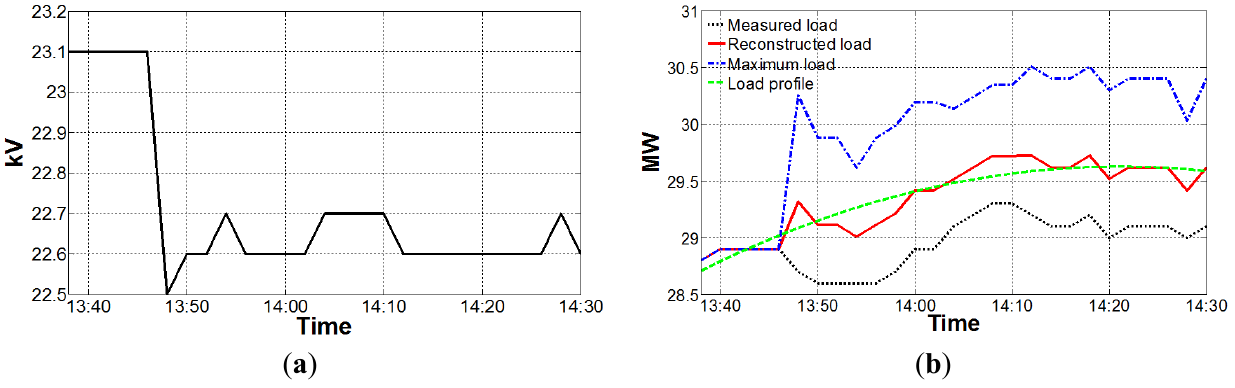
Figure 2. Results of the nationwide CVR implemented at the 108th transformer bank on 9 August 2012: ( a ) measured bank voltage; and ( b ) transformer-bank